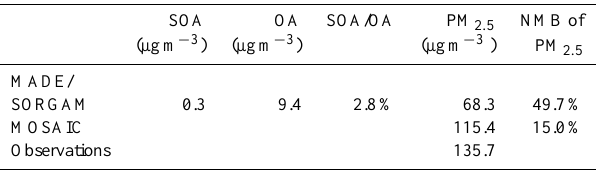
Table 4. Modeled SOA, OA and PM 2 . 5 using MADE/SORGAM and MOSAIC in comparison with observations. The data shown are spatially averaged over 71 big cities and temporally averaged during 6–10 January 2013. SOA OA SOA/OA PM 2 . 5